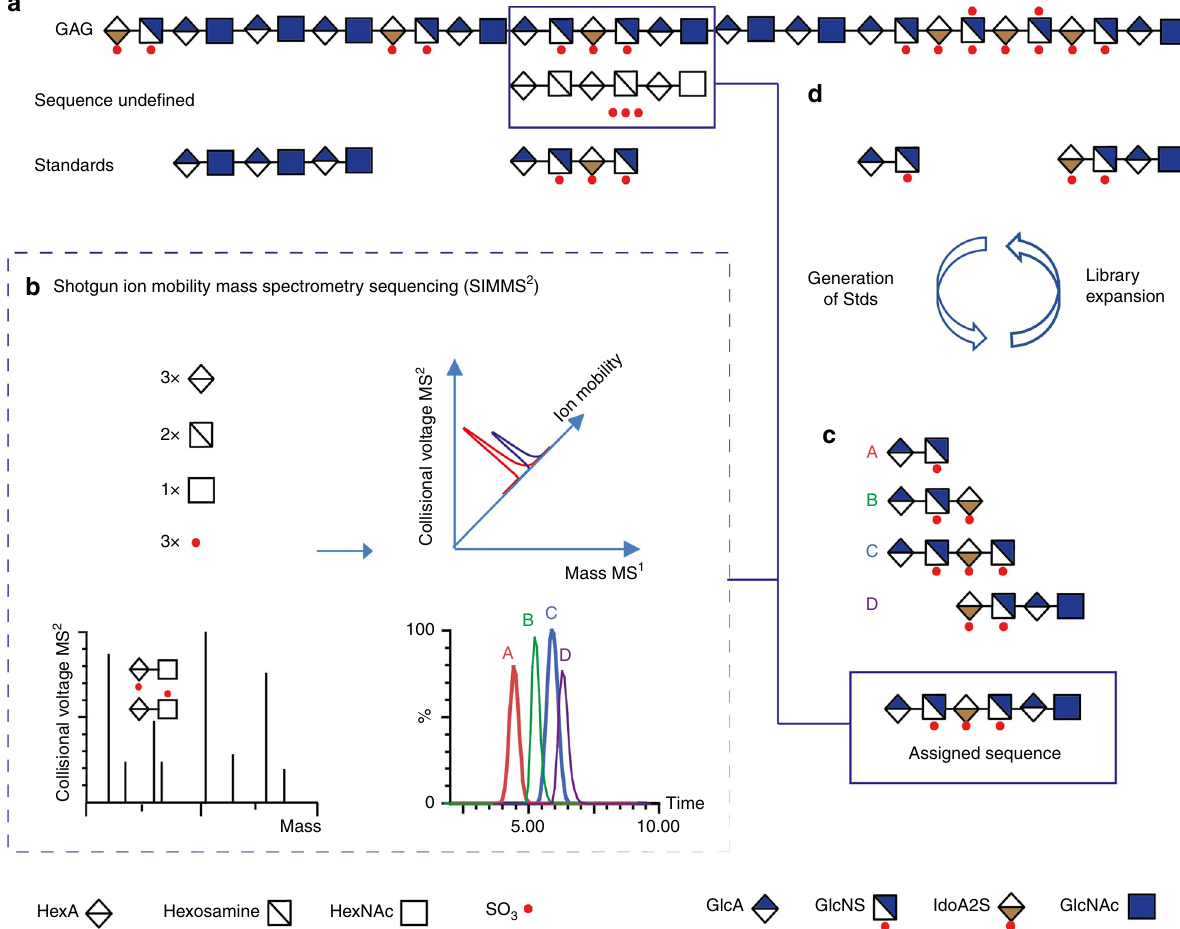
Fig. 1 Graphic depiction of the SIMMS 2 strategy for de novo sequencing of HS saccharides. a Heparin and HS contain variant domains including unmodi fi ed acetylated domains (with high levels of GlcNAc residues), transition domains (GlcNAc and GlcNS containing residues), and sulfated domains (high levels of GlcNS and O -sulfation). A library of shorter oligosaccharide standards were generated. b Illustration of MS and MS/MS to provide mass and the ability of ion mobility mass spectrometry (IMMS) to provide a third dimension that distinguishes isomers with collision cross section (CCS) values. c The availability of MS, MS/MS, and IMMS data from a library of known standards ( a , b ) then allows a strategy for unambiguous sequencing of unde fi ned oligosaccharides based on comparison with standards. d Illustration of the iterative loop process for expansion of the CCS dataset necessary to further develop the SIMMS 2